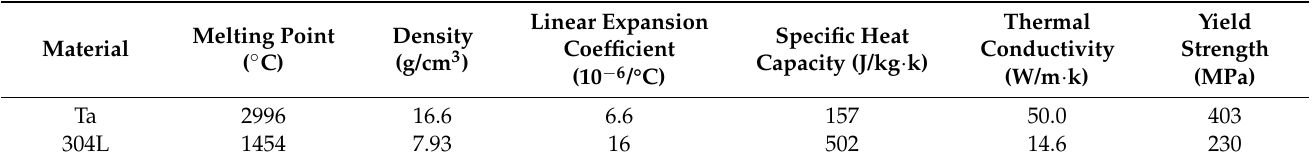
Table 3. Main thermal and mechanical properties of Ta and 304L stainless steel.